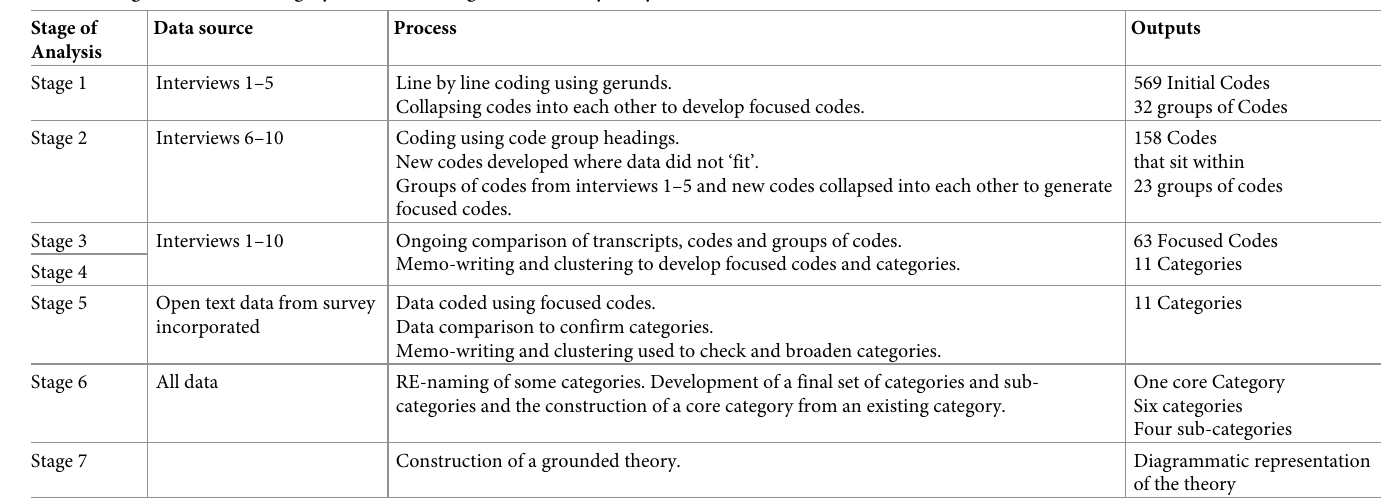
Table 2. Stages of code and category construction in grounded theory